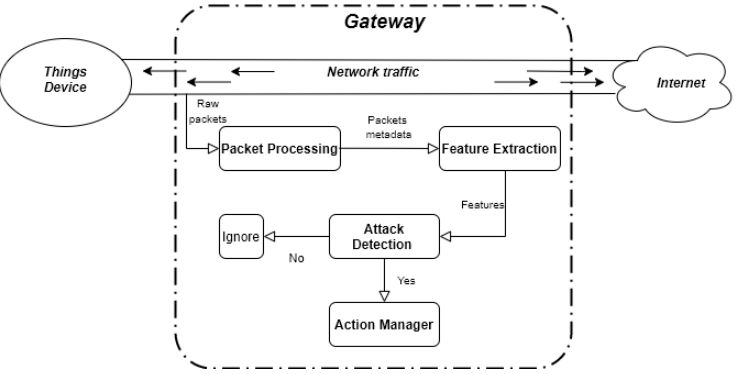
Figure 1. The workflow of the Realguard